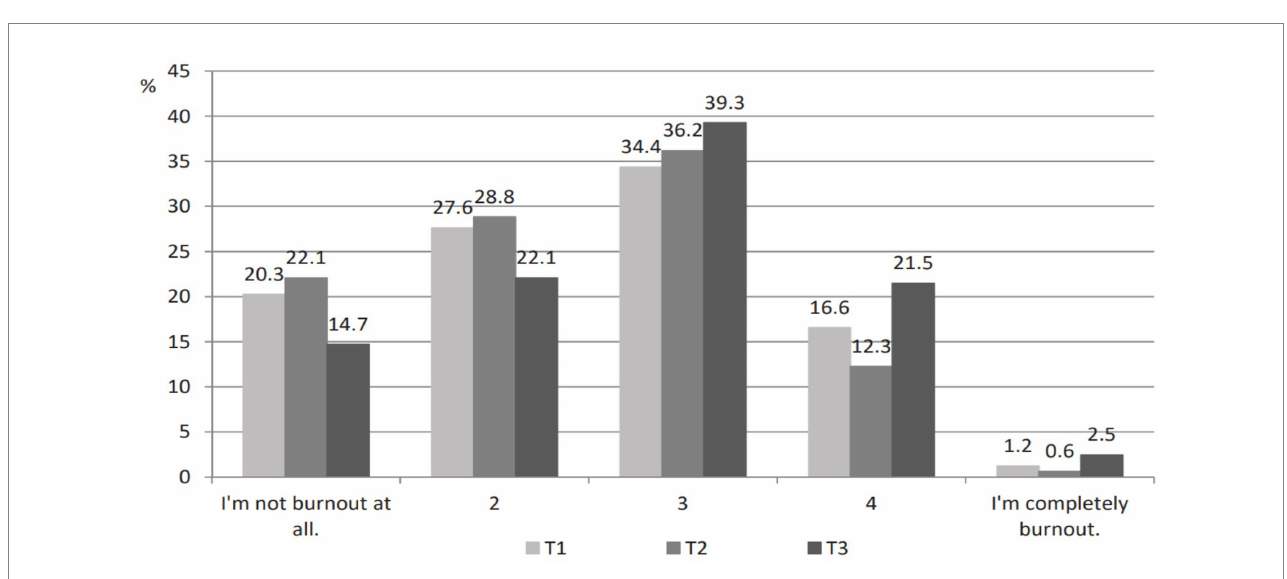
FIGURE 2 SFB in three time points—percentage of teachers.